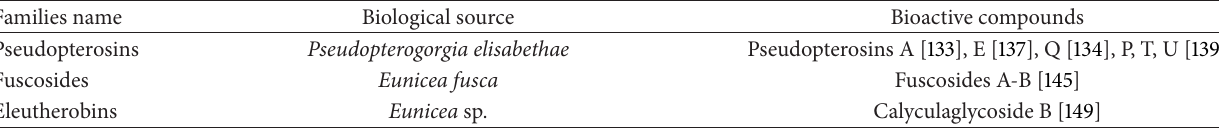
Table 4: Glycosides diterpenes.